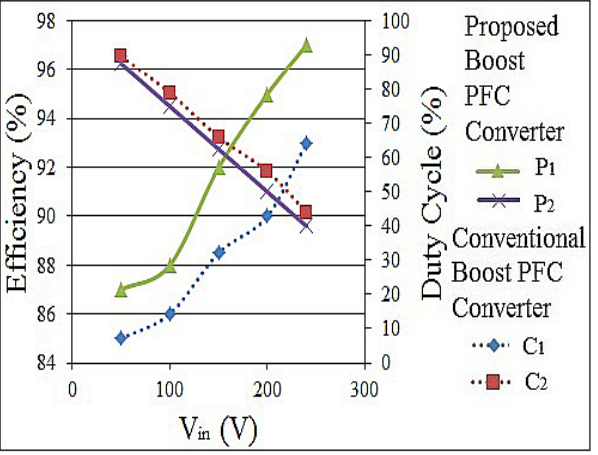
Figure 10. Output power and efficiency.